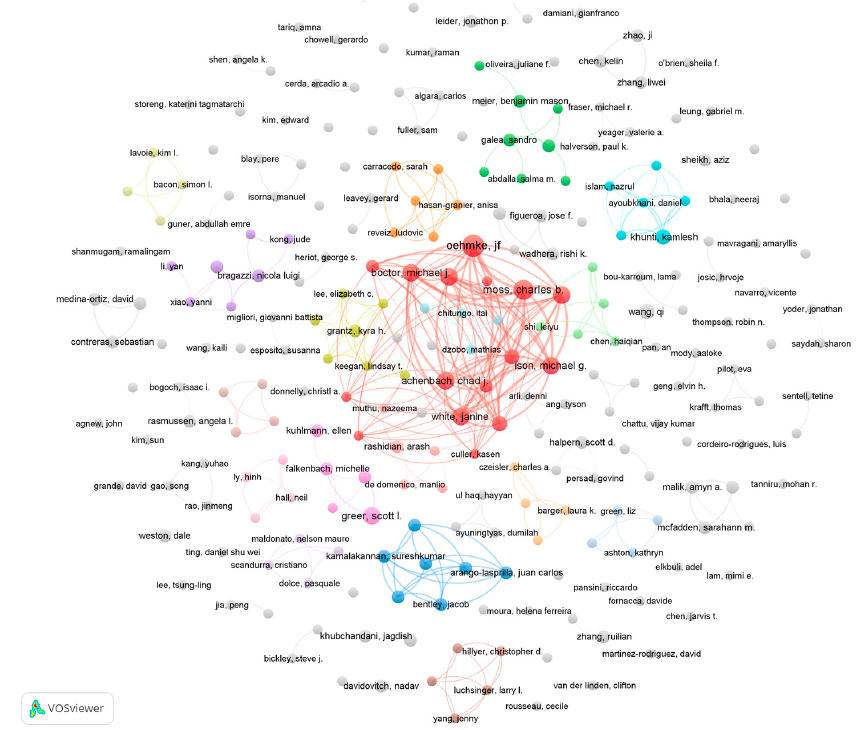
Figure 3. The co-authorship network of authors (publications). Note(s): Node size represents the number of publications. Node colour refers to clusters. The links refer to co-authorship.